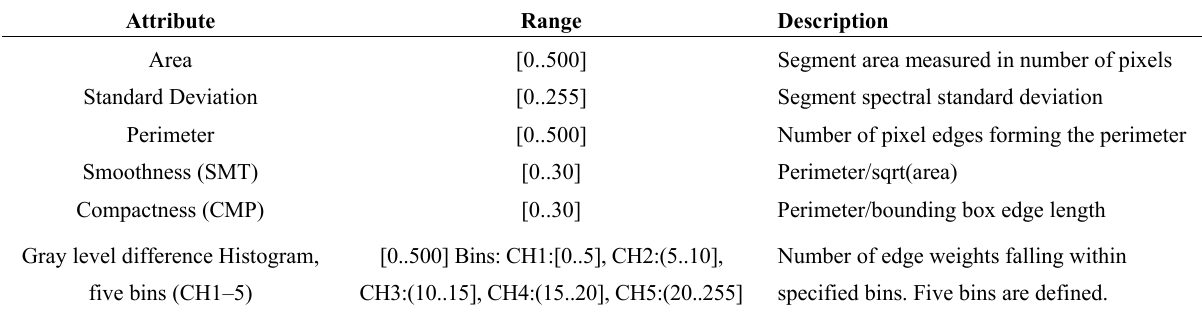
Table 2. Implemented attributes for consideration in the context of CC segmentation, specifically in the CC + Attr and CC + Attr + Map method